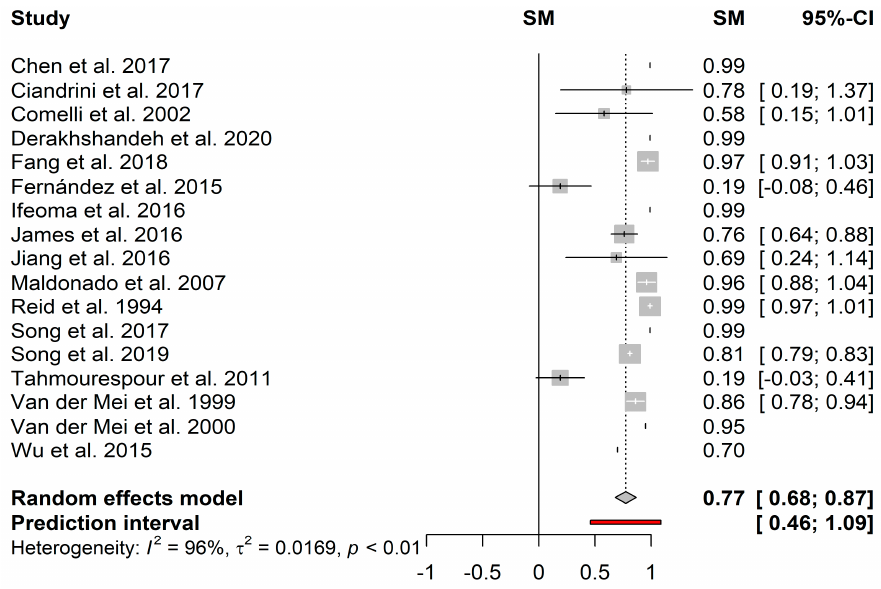
Figure 5. Forest plot of the pooled effect estimates for the proportion of biofilm reduction induced by cells. The vertical dashes represent the effect estimate, and the horizontal line is the respective confidence interval at 95% (95%–CI) obtained for each study. Gray squares represent the standard deviation of each study, while the gray diamond represents the pooled effect estimates. The red bar represents the predictive interval. Heterogeneity test: I 2 – I 2 test; τ 2 –Tau-squared test.